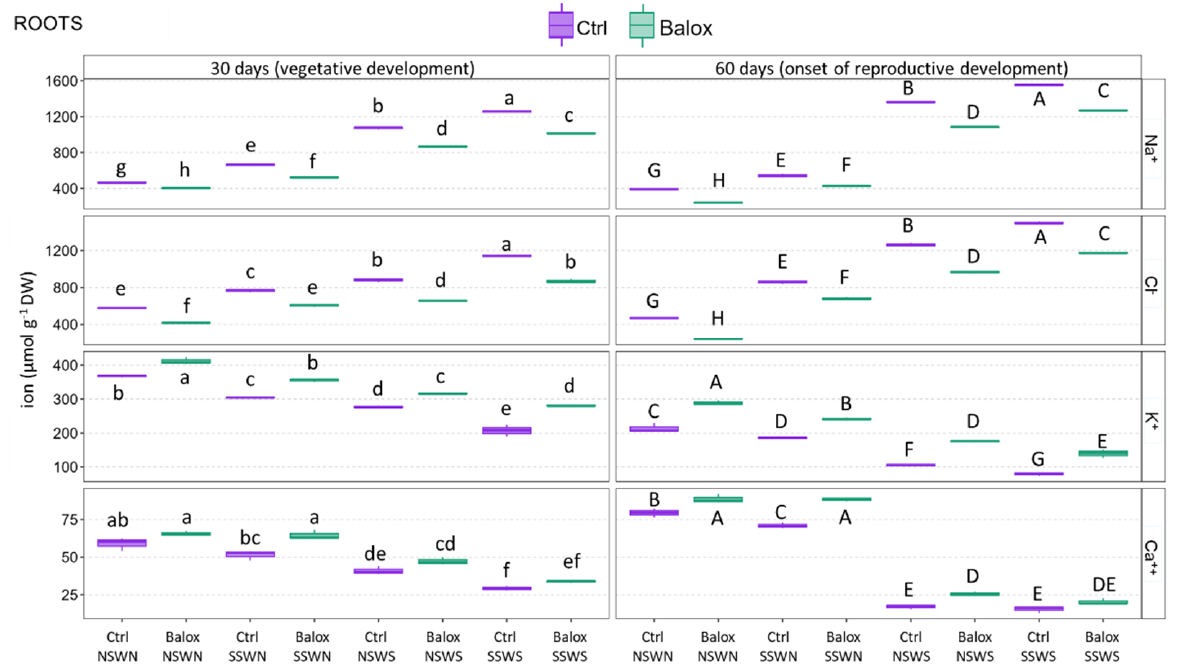
Figure 6. Ion contents in roots: sodium (Na + ), chloride (Cl − ), potassium (K + ), and calcium (Ca 2+ ) in tomato plants subjected to increasing salinity by different combinations of saline or non-saline soil and irrigation water; the plants were treated, or not, with the biostimulant containing polyphenols at 1.4% ( w / w ) and glycine betaine at 3.0% ( w / w ) at a dose of 0.4 mL L −1 of irrigation water. The control treatments without biostimulant (Ctrl) and with biostimulant (BALOX ® ) are defined as follows: (i)